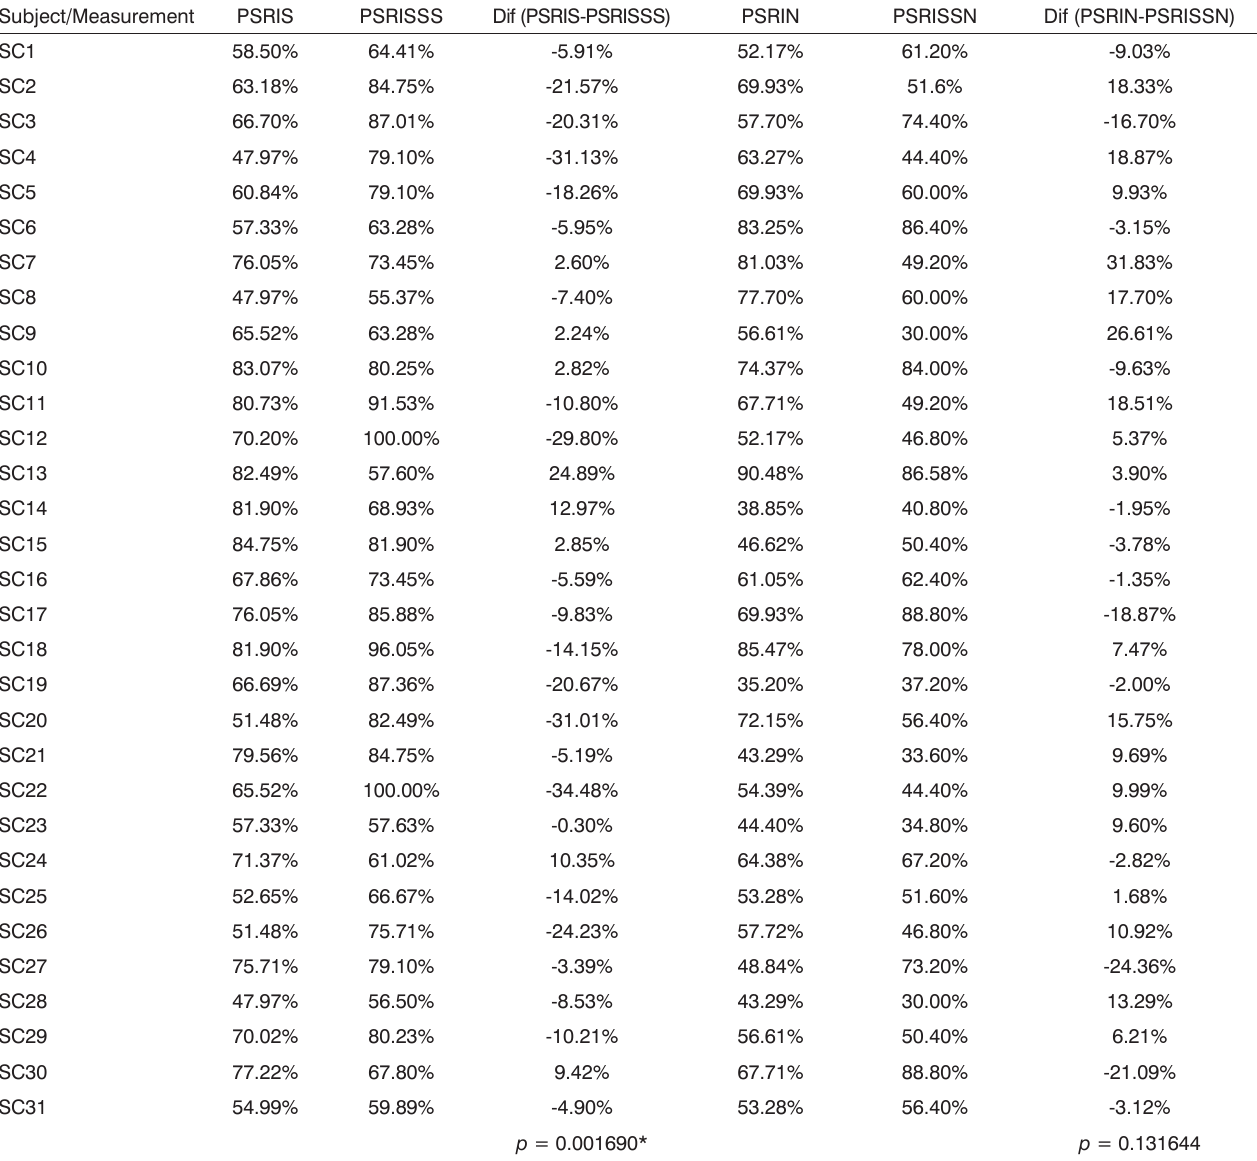
Table 1. Percent Sentence Recognition Indices and differences in performance on both tests of subjects in the control